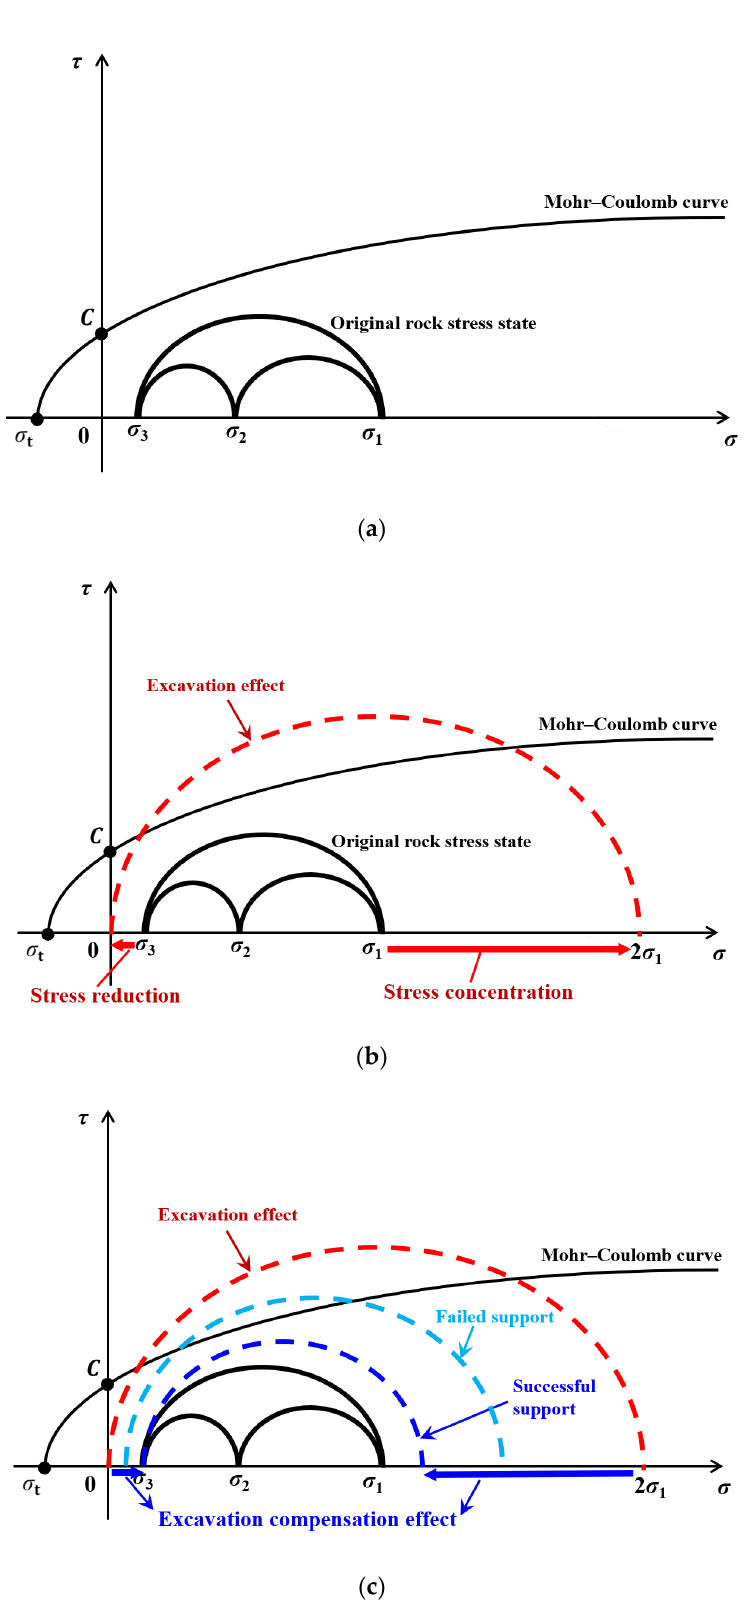
Figure 14. Mohr–Coulomb theory: ( a ) original rock stress state; ( b ) excavation effect; ( c ) excavation compensation effect.